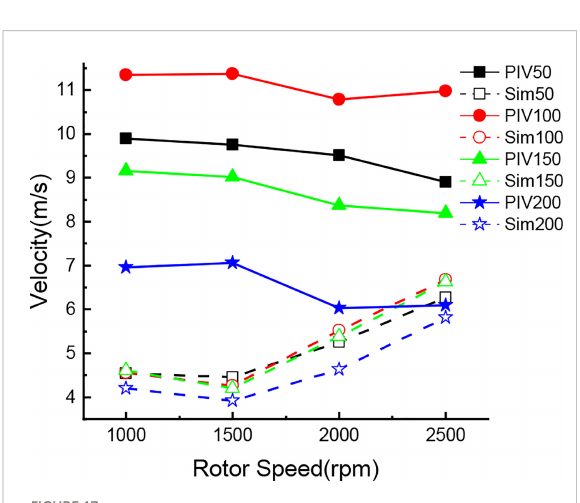
FIGURE 17 The change trend of the mean value of PIV and numerical